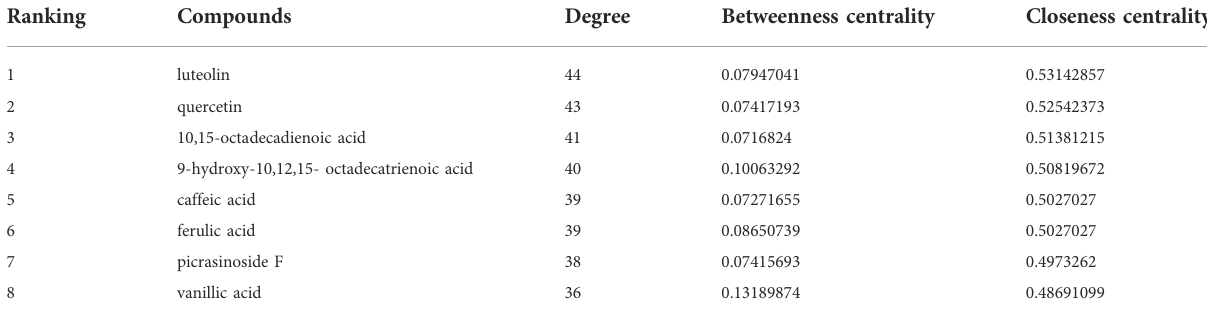
TABLE1 The topological parameters of compounds from the dandelion extract ranked Top